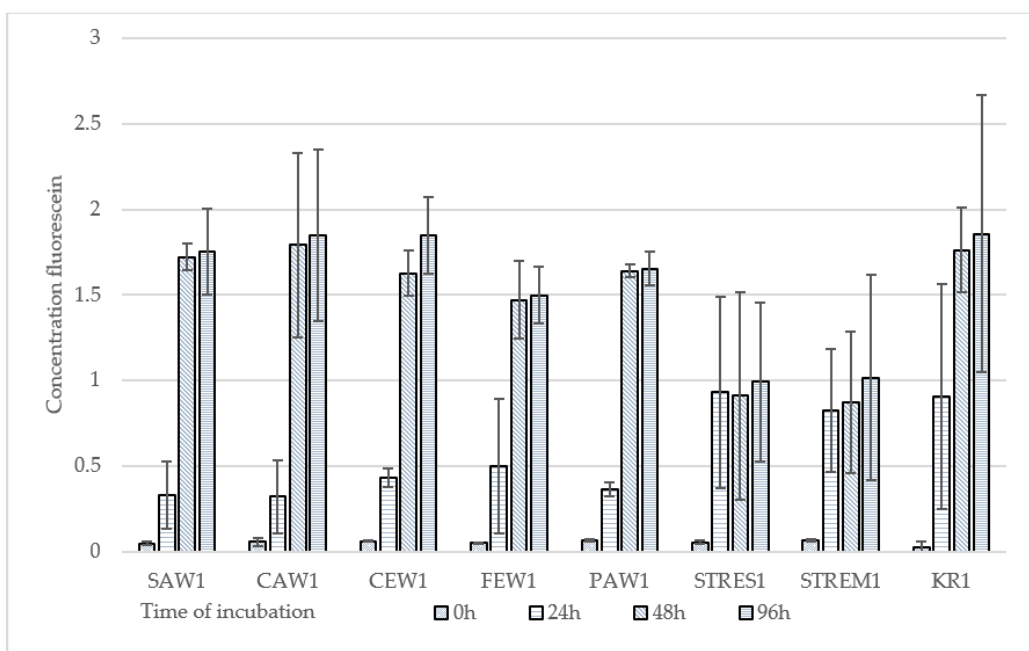
Figure 4. Changes in the concentration of dehydrolyzed fluorescein aglycone during the incubation of selected microorganisms with FdB. SAW- Staphylococcus aureus , CAW- Candida albicans , CEW- Escherichia coli , FEW- Enterococcus faecali , PAW- Pseudomonas aeruginosa , STRES- Streptococcus sanguinis , STREM- Streptococcus mutans . KR1-sample of kefir commercially avaible in local store. Typical looks from experiment 96-well plate (Figure. S2)